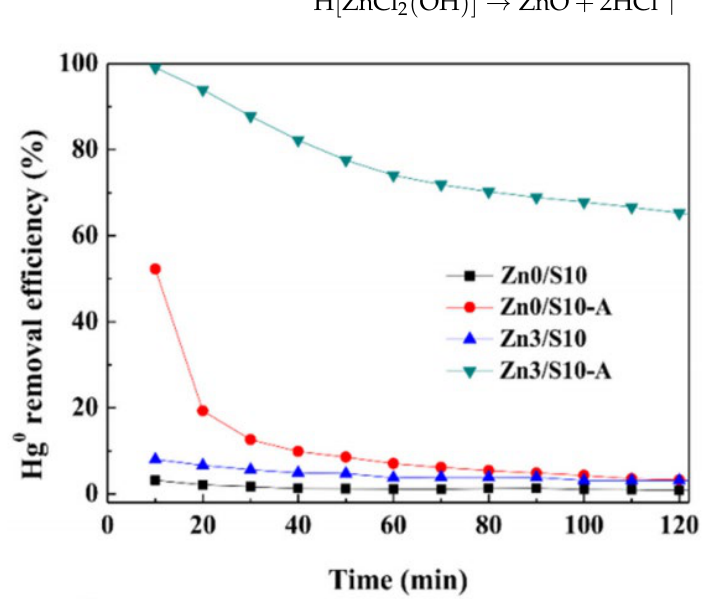
Figure 2. Hg 0 removal performance of different ZnS sorbents at different temperatures [37]. Reprinted/adapted with permission from Ref. [37]. 2019, Fuel Processing